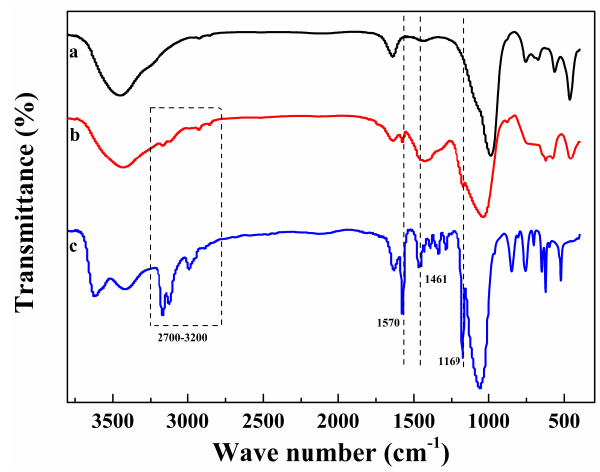
Figure 4. FT-IR spectra of: (a) CaX, (b) IL/CaX, (c) [Emim][BF 4 ].